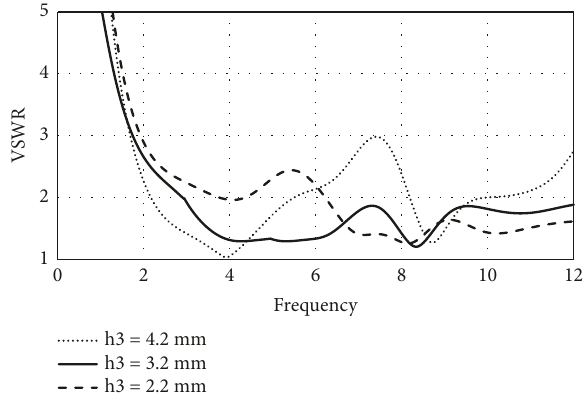
Figure 8: Comparison of simulated and measured radiation effi- ciency ( 𝜂 ) and gain ( 𝐺 ) of the proposed tri band-notched UWB